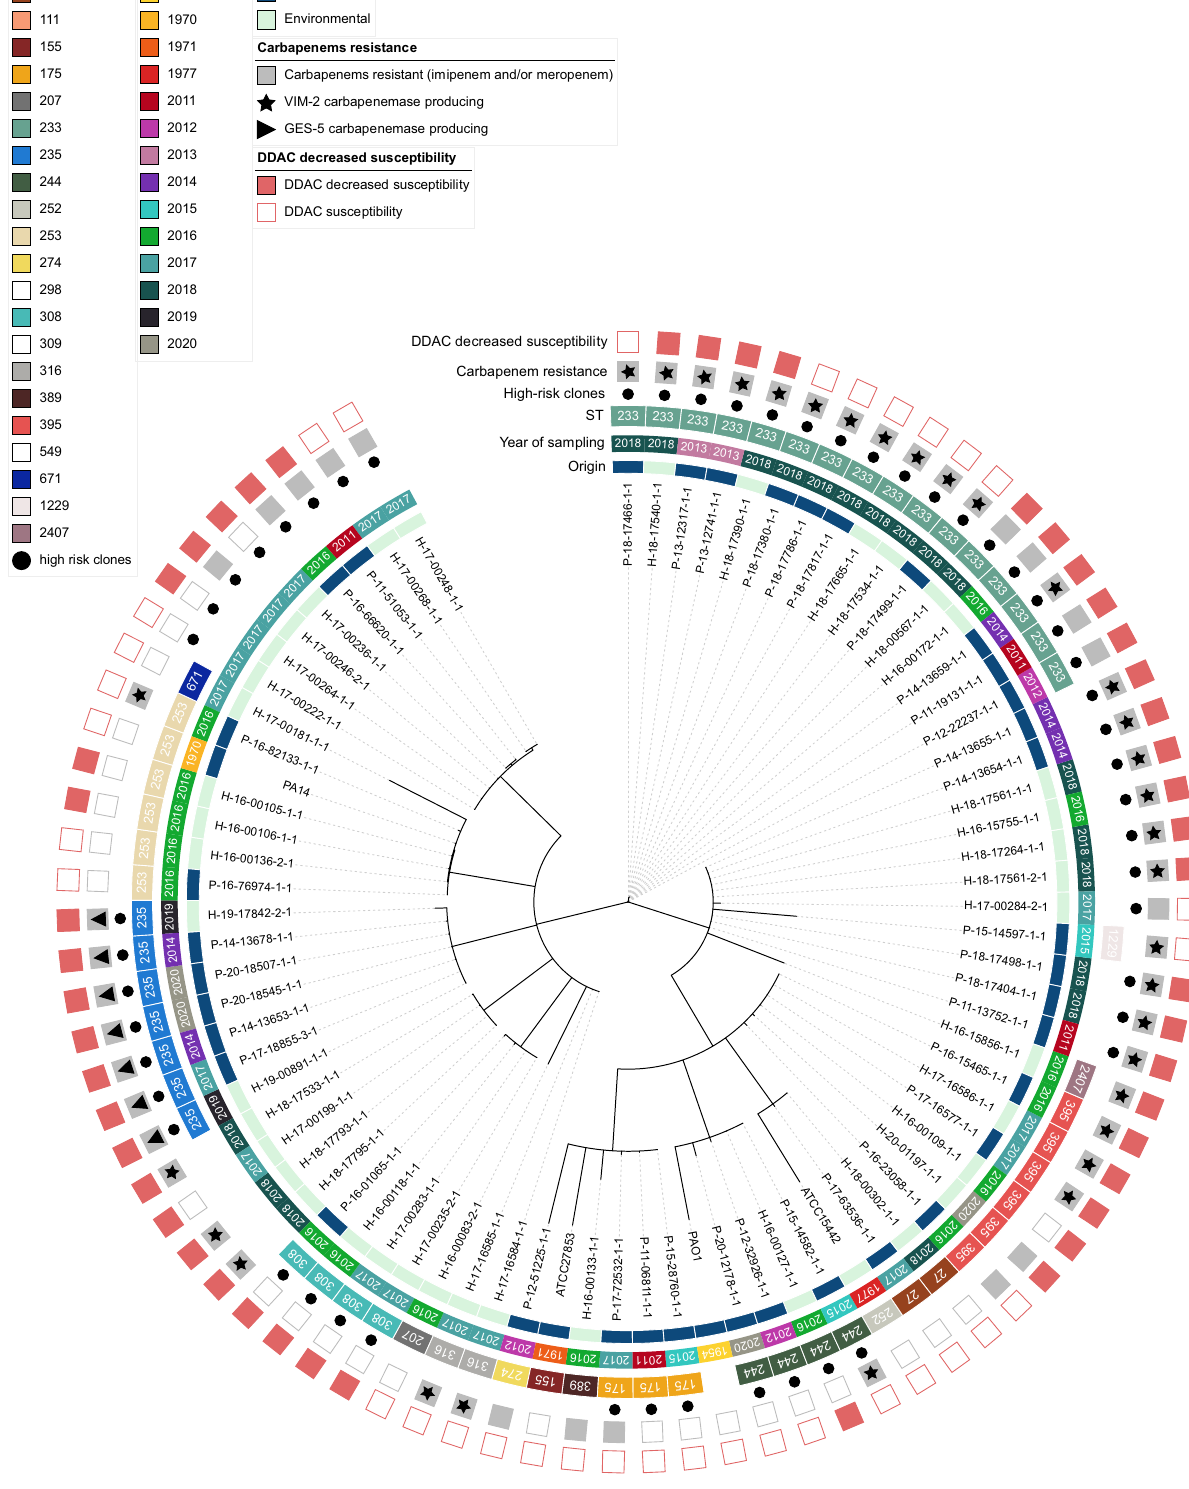
Figure 4. Minimum spanning tree of 77 strains from panel for genomic characterization compared with reference strains (PAO1, PA14, ATCC15442 and ATCC27853). Core genome MLST clustering according to the cgMLST Pseudomonas aeruginosa scheme published by Tönnies et al. 32 . The tree was surrounded by the following information: the origin of the strains (patient, P or hospital environment, H), year of sampling, sequence type (ST), carbapenem resistance phenotype, whether it was associated with a VIM-2 or GES-5 carbapenemase, and decreased susceptibility phenotype to DDAC (didecyldimethylammonium chloride). GES-5: strains producing the class A carbapenemase GES-5; VIM-2: strains producing the class B carbapenemase